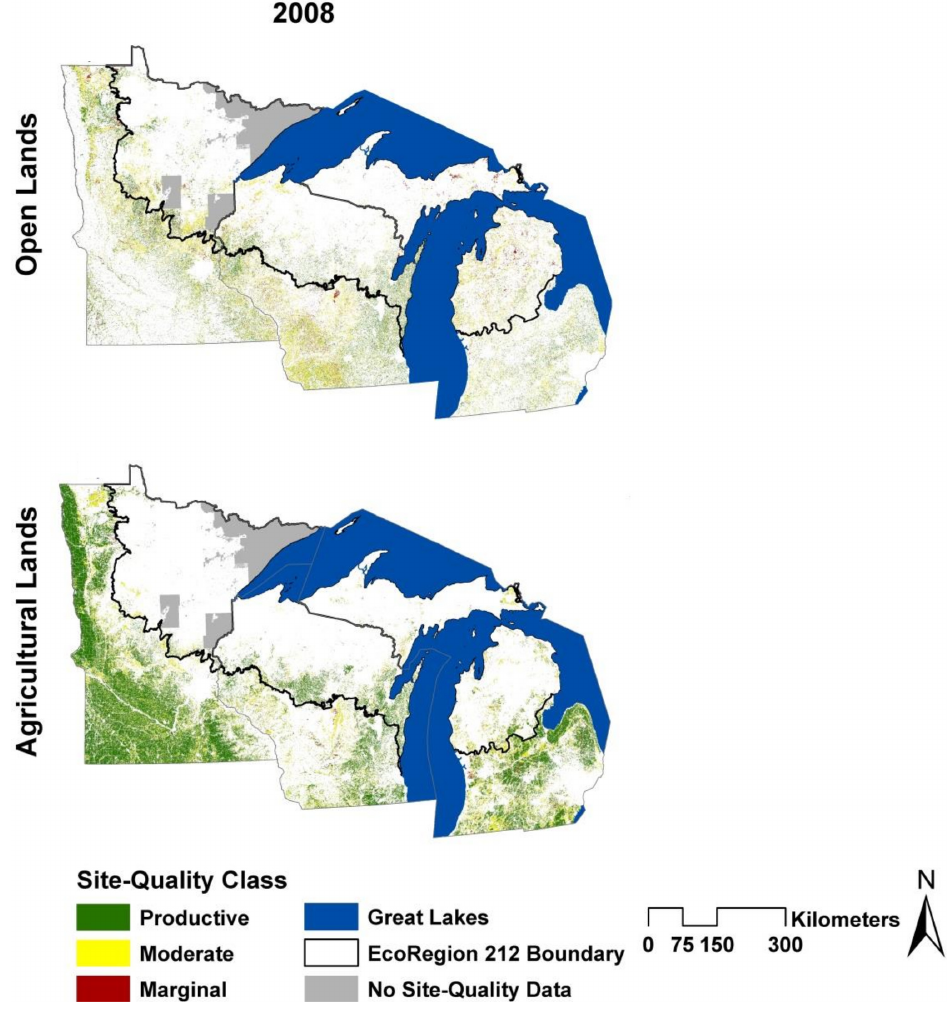
Fig 3. Pixels used in the “ Biophysical Land Identification ” analysis (Fig 2). The data have been filtered to remove single pixels and areas in public holding. Each pixel has been color-coded to indicate its site- quality